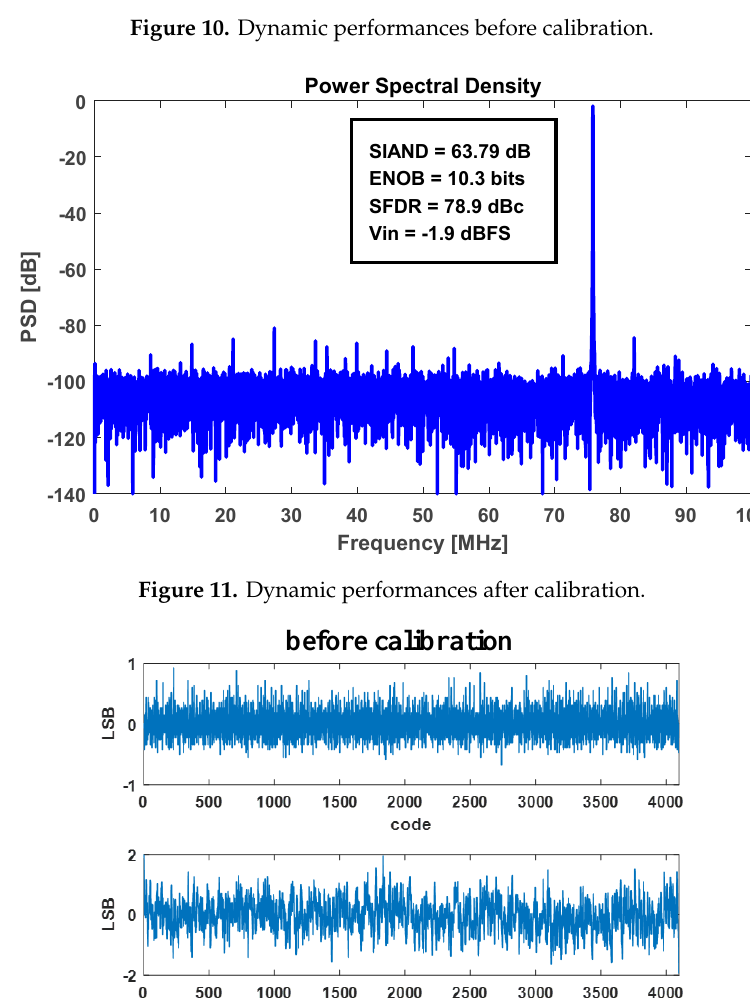
Figure 10. Dynamic performances before calibration.